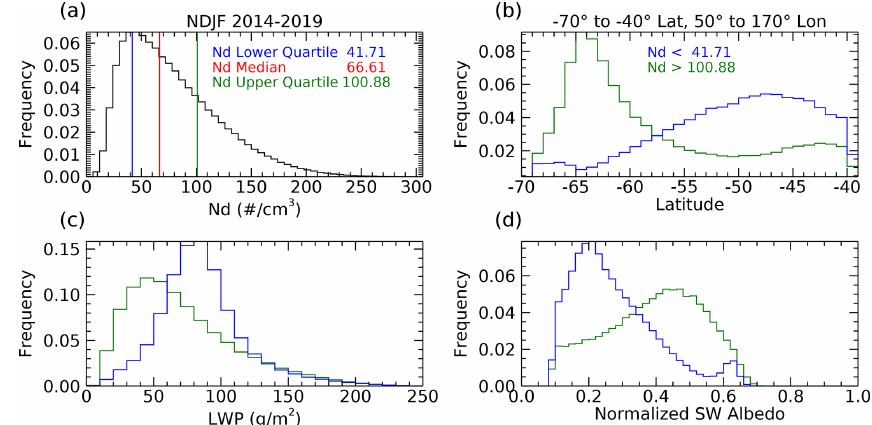
Figure 2. (a) N d frequency distribution from the cloud scenes in the analysis domain during the 5 years of summer months analyzed. Colored vertical lines are defined in the inset. (b) The latitudinal distributions of the cloud scenes that compose the high- and low- N d quartiles. (c) the distributions of LWP for the high- and low- N d quartiles, (d) the distribution of normalized CERES solar albedo of the high- and low- N d quartiles. The normalization procedure is described in the Appendix. The colors of the histograms in panels (b) , (c) and (d) are as described in the inset of panel (a) .